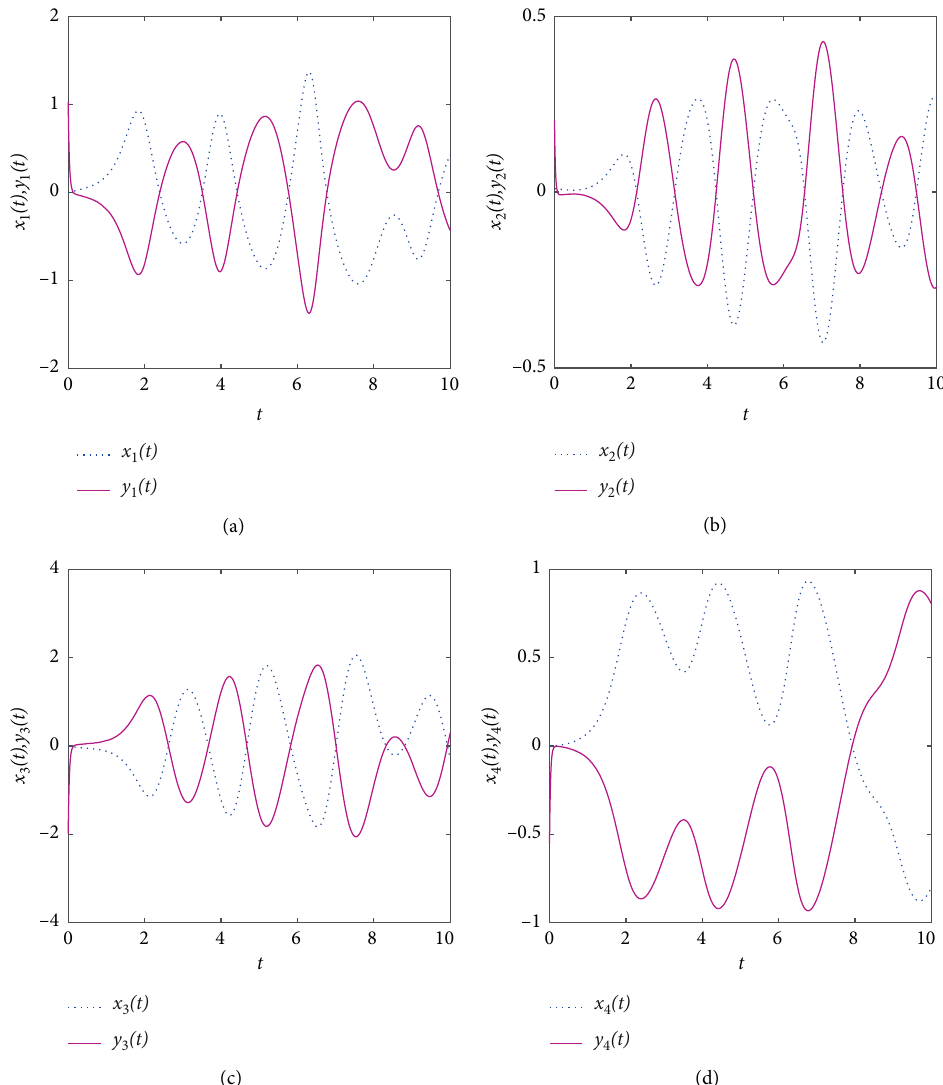
Figure 4: Dynamical behaviors of the drive system (13) and the response system (14) with periodic intermittent controller (15), where 𝛼 = 0.985